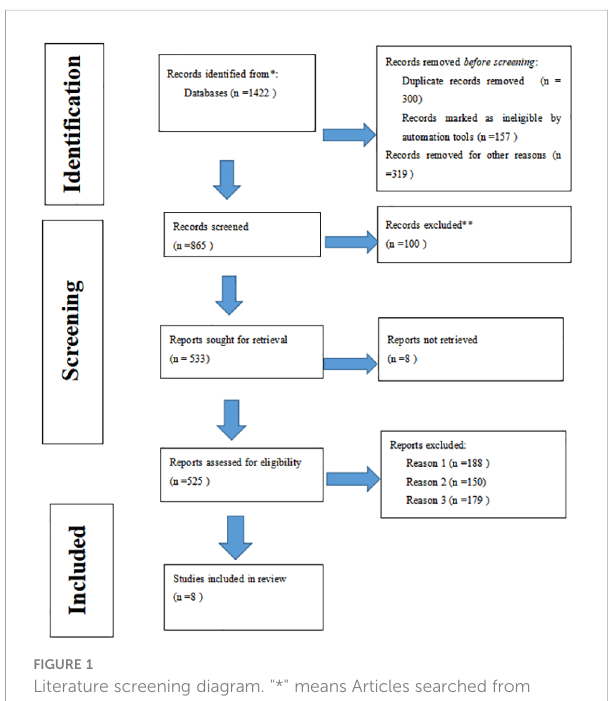
FIGURE 1 Literature screening diagram. "*" means Articles searched from Database. "**" means Duplicate